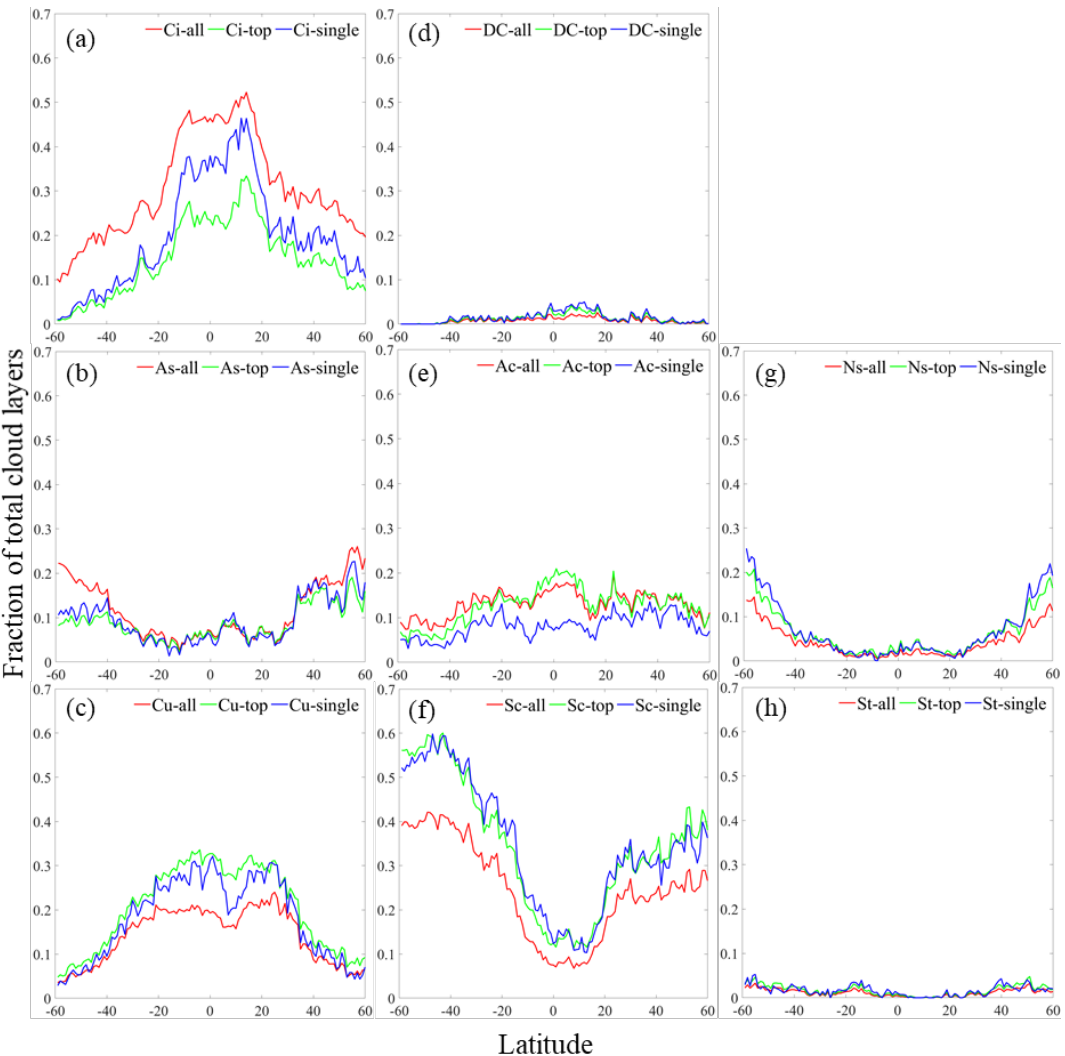
Figure 9. Fractional distribution of the eight types of clouds identified by the NSRM algorithm during the nighttime over the tested period. Each panel presents the distribution of one of the eight cloud types, in terms of all cloud layers (all), the uppermost cloud layer (top), and the single layers (single). The panels are arranged from high, thin clouds to low, thick